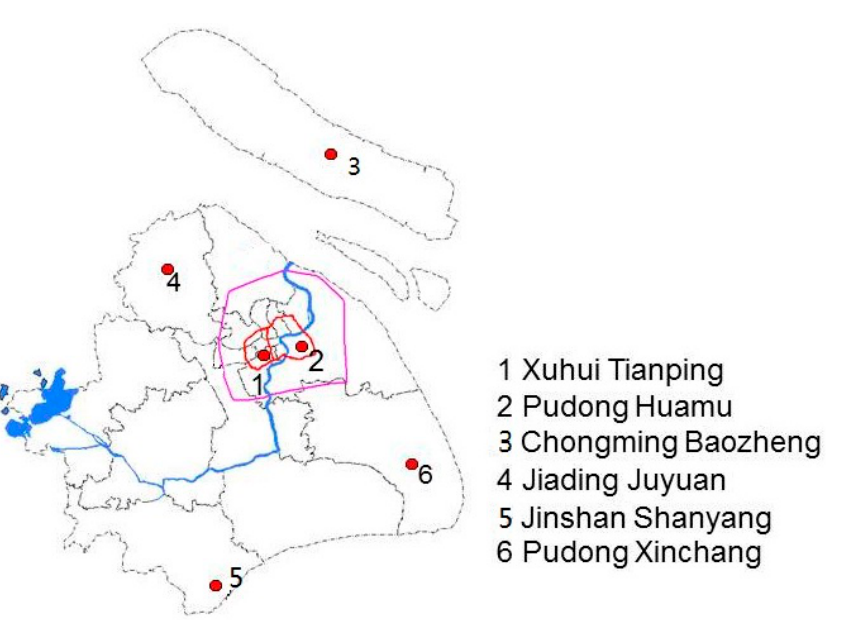
Figure 1. Map of the participating communities in urban and suburban/rural areas of Shanghai (the label of each community consists of the administrative district name and the community name).